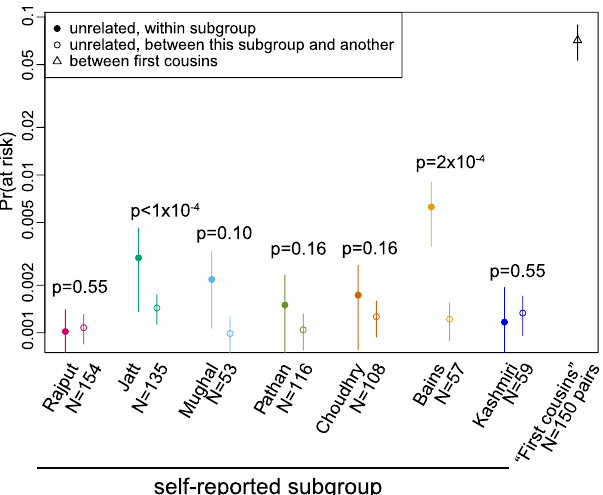
Fig. 6 Estimated fraction of couples from intra-biraderi, inter-biraderi and fi rst cousin unions who would be at risk of having a child with a recessive developmental disorder. These estimates are based on simulations that use P/LP variants ascertained from exome-sequence data in Bradford Pakistani mothers, and rely on the self-reported subgroup information. The y -axis indicates an estimate of the fraction of couples that would be ‘ at risk ’ of having a child with a recessive developmental disorder since both parents are carriers of P/LP variants in the same gene. Note that this is undoubtedly an under-estimate of absolute risk (see ‘ Discussion ’ ), but one can still compare the relative risk for intra - versus inter-biraderi unions. Error bars indicate standard deviations of the risk estimates and one-sided p-values are from permutation tests (see ‘ Methods ’ ). The ‘ fi rst cousins ’ were sampled to match the IBD distribution observed for self- reported fi rst cousin couples (see ‘ Methods ’ ), regardless of biraderi